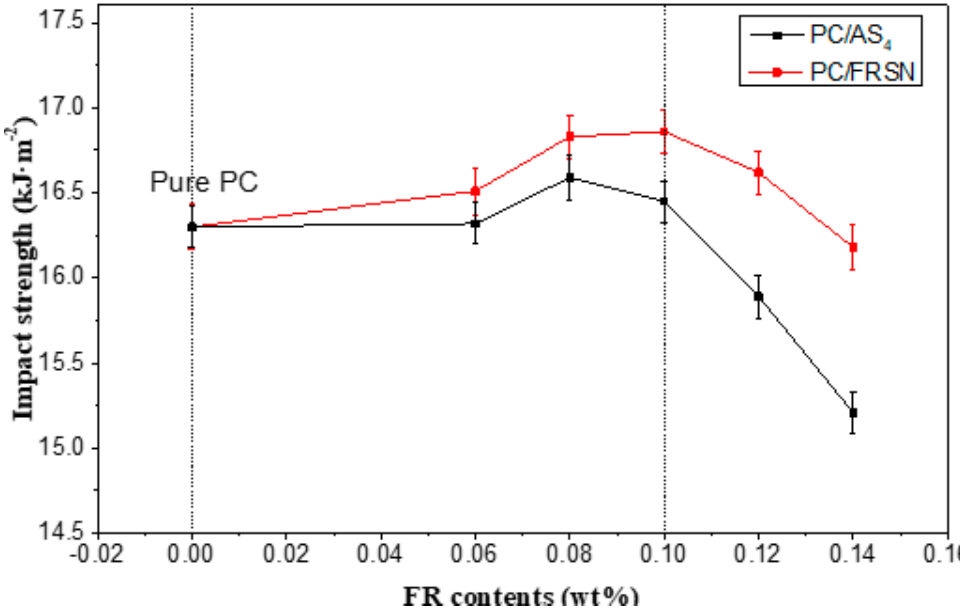
Figure 6. Notch impact strength of PC composites with different FR contents. Materials 2020 , 13 , x FOR PEER REVIEW